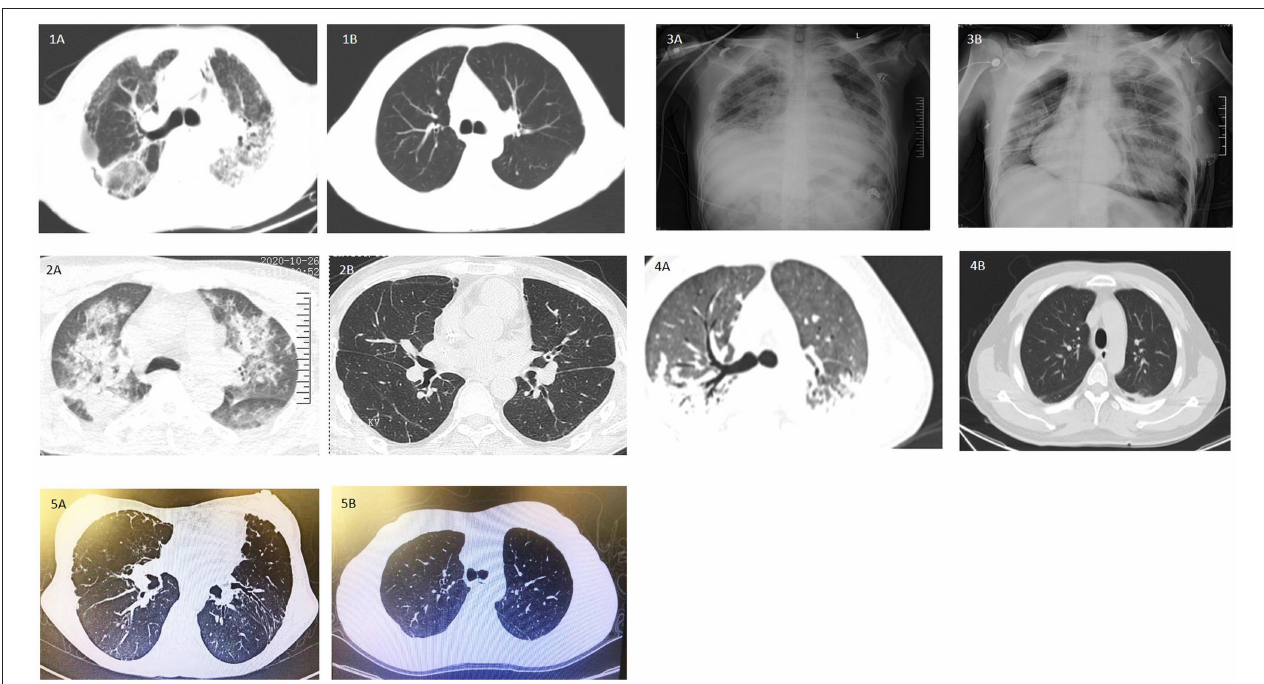
FIGURE 1 | CT images of five patients pre-lung transplantation and post-lung transplantation. (1A − 4A) Progression of bilateral lung fibrosis with consolidation were shown in case 1–4. (1B, 2B, 4B, 5B) Post-lung transplantation CT manifestation without significant abnormality. (3B) Chest imaging showed significant lung effusion and edema in Case 3. (5A) Case 5 suffered deteriorated graft function after 5 years of transplantation and chronic lung allograft dysfunction was